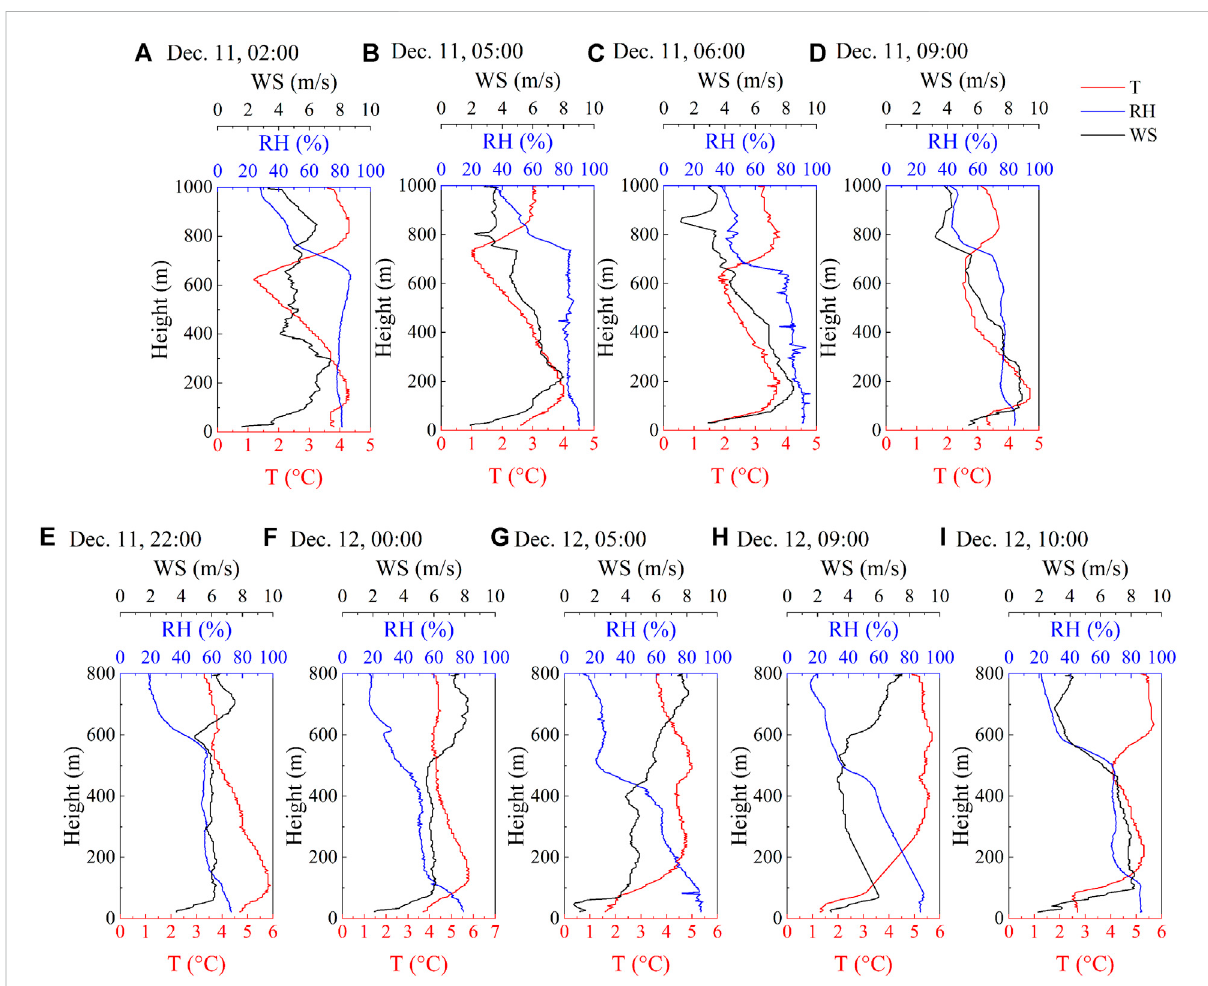
FIGURE 5 Verticalpro fi lesofambienttemperature(T),relativehumidity(RH),andwindspeed(WS)duringdifferentphasesoftwopersistentfogcases.[ (A) . pre-formation, (B) .formation, (C) .mature,and (D) .dissipation phaseofthe fi rstfog; (E) .pre-formation, (F) .formation, (G) .development, (H) .mature, and (I) . dissipation phase of the second